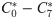
Model structure.Compartmental model for female tsetse populations. Pupae (P) are deposited at a rate Λ, proportional to the number of adult females in categories 1–7. Pupae die at a rate μp, taken to be a function of pupal density and temperature. Pupae hatch at a rate h, becoming category 0 flies (C0). C0, C1, C2, and C3 correspond to flies that have ovulated 0,1, 2, and 3, times respectively, while C4 –C7 are aggregated categories of flies such that Cx for x = 4, 5, 6, or 7 corresponds to the total number of flies have ovulated x+4n times, where n is a whole number. Category 0 flies progress to category 1 at a rate of 1/6 per day. Category 1–7 (C1 –C7) flies progress to the next category at a rate of 1/9 per day, with category 7 flies progressing to category 4. All adult flies (C0 –C7) have a mortality μa, a function of temperature. C0*−C7* correspond to the number of flies available for sampling, i.e. susceptible to capture with traps; flies in category 0 and 1 flies are assumed to have lower probabilities of capture than older flies.